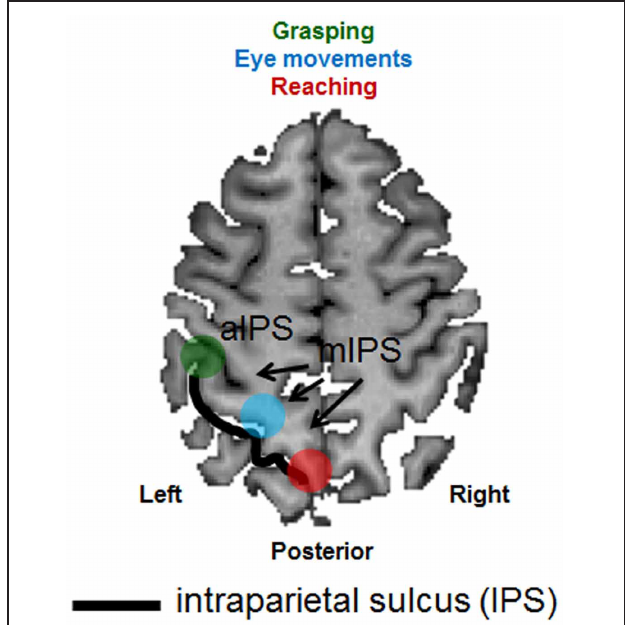
FIGURE 1 | Schematic representation of the anatomical and functional organization of the posterior parietal cortex. An axial (horizontal) slice through the brain of a healthy individual has been chosen to depict the major sulcus within the posterior parietal cortex, the intraparietal sulcus (IPS—outlined by the use of a black line). Functional areas selective for grasping (depicted in green), reaching (depicted in red) and eye movements (depicted in light blue) have been superimposed. aIPS, anterior IPS; mIPS, medial